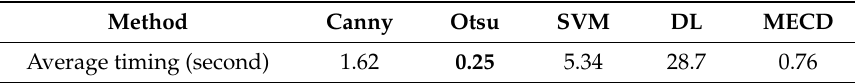
Table 3. Average timing of processing the test concrete